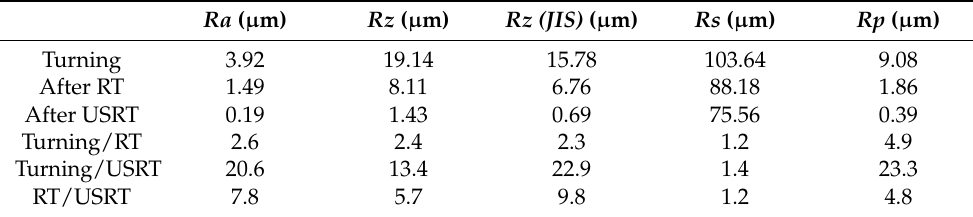
Table 1. Surface roughness for the AISI 304 stainless steel pipe inner surface before and after the RT and USRT